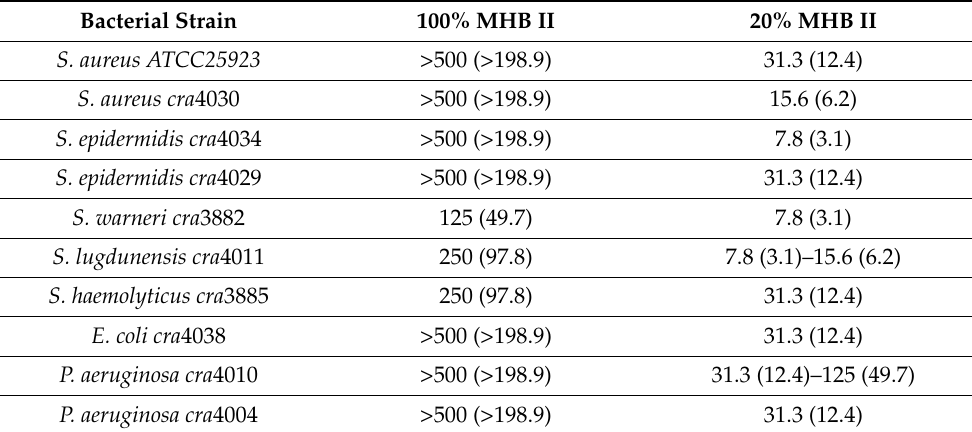
Table 2. MBC values obtained in undiluted and diluted MHB